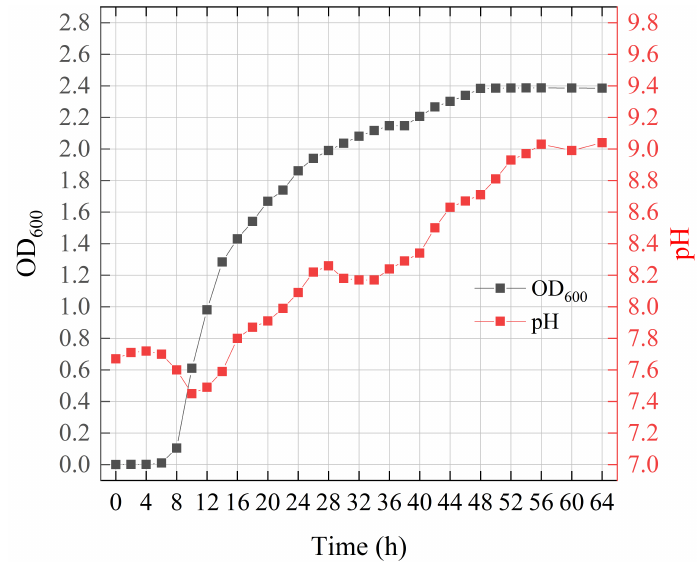
Figure 2. Monitoring of growth and pH changes in cultivation